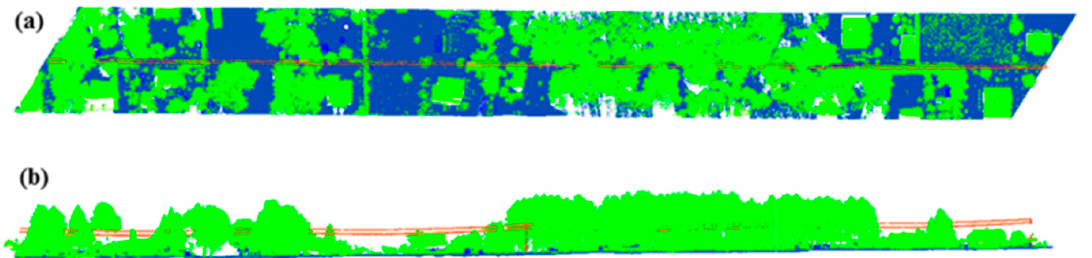
Figure 3. Classified ALS point cloud provided by Vimap: ( a ) top and ( b ) side view (green—objects above the ground: vegetation, buildings, blue—ground, red—power lines).